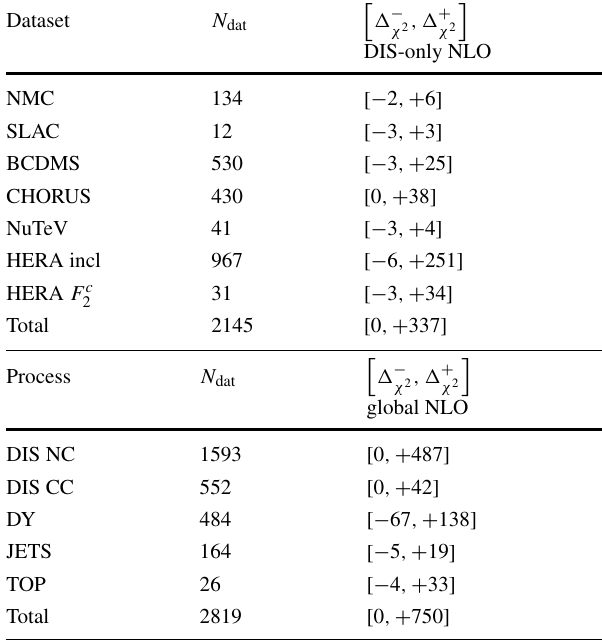
Table 16 The values of (cid:4) ± χ Eq. (B.2) for DIS-only and global PDFs. 2 The maximum and minimum of the χ 2 are evaluated for the PDF sets listed in Table (13)